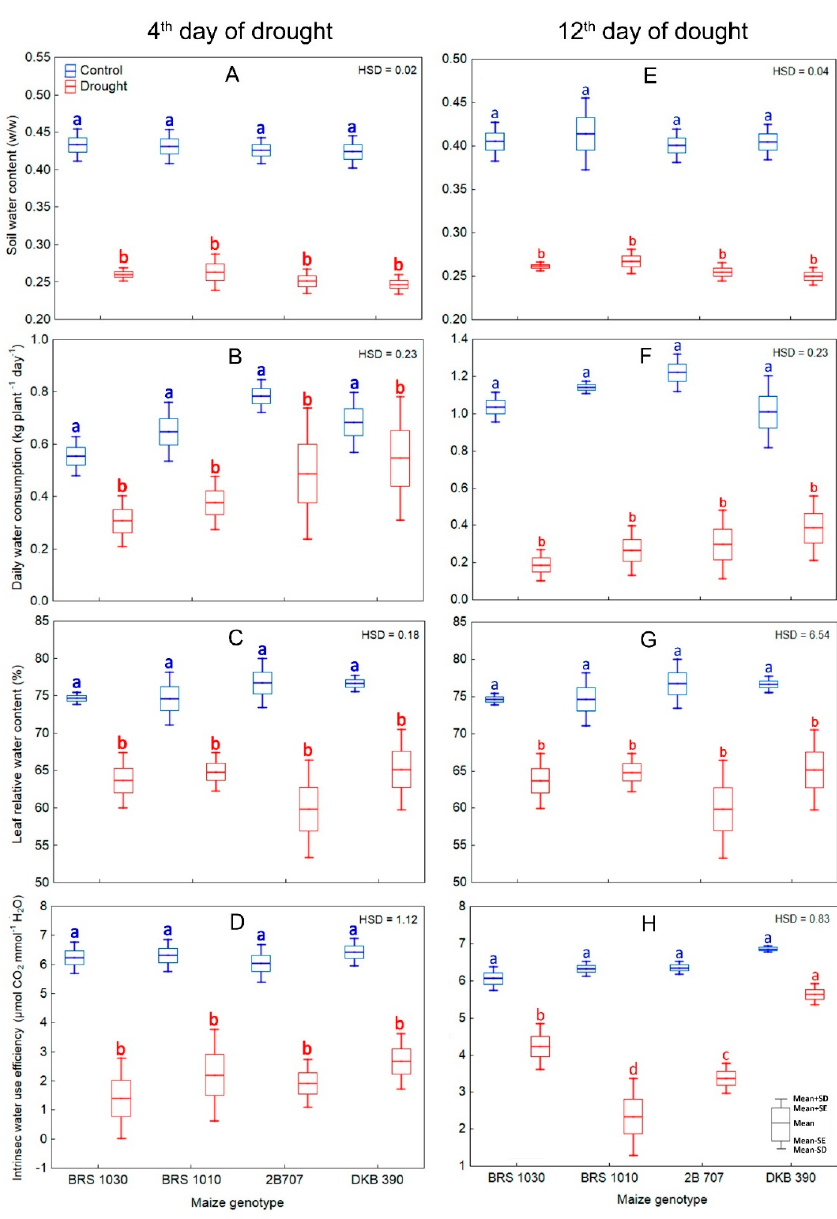
Figure 4. Water parameters for control and drought stressed maize plants in the 4th and 12th day of stress. ( A , E ) Soil water content, ( B , F ) leaf relative water content, ( C , G ) daily water consumption and ( D , H ) intrinsic water use e ffi ciency in plants of maize genotypes grown in soil at field capacity (control) or subjected to water shortage (drought) at pre-flowering stage. 4th day: ( A – D ) showed significant di ff erences among treatments regardless of genotype ( p < 0.01) which indicates that the means of the genotypes should be compared between the treatments. Boxes from the same genotype under di ff erent treatments, topped by the same letter, are not statistically di ff erent according to Tukey’s test ( p < 0.05). 12th day: ( E – G ) showed significant di ff erences among treatments regardless of genotype ( p < 0.01) which indicates that the means of the genotypes should be compared between the treatments. Boxes from the same genotype under di ff erent treatments, topped by the same letter, are not statistically di ff erent according to Tukey’s test ( p < 0.05). ( H ) showed significant interaction between treatment and genotype ( p < 0.01) which indicates that the means of the genotypes should be compared by treatment. Boxes from di ff erent genotypes under the same treatment, topped by the same letter, are not statistically di ff erent according to Tukey’s test ( p <